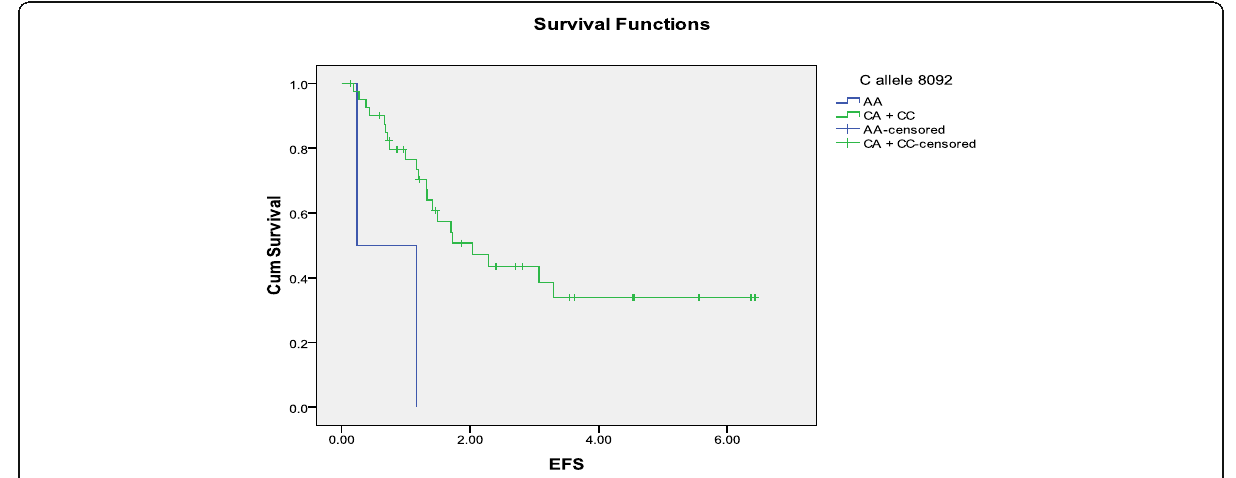
Fig. 2 Kaplan-Meier plot of EFS (Years) according to ERCC1 8092 C allele